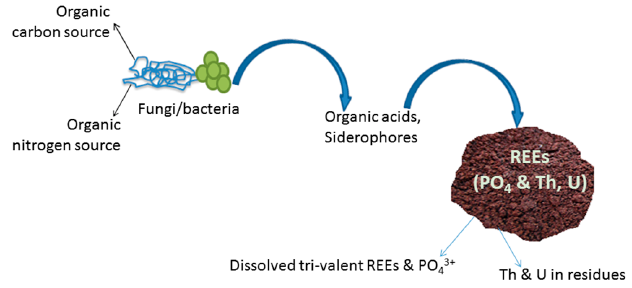
Figure 4. Bio-reclamation of rare earth elements by interactions with heterotrophic microbes.